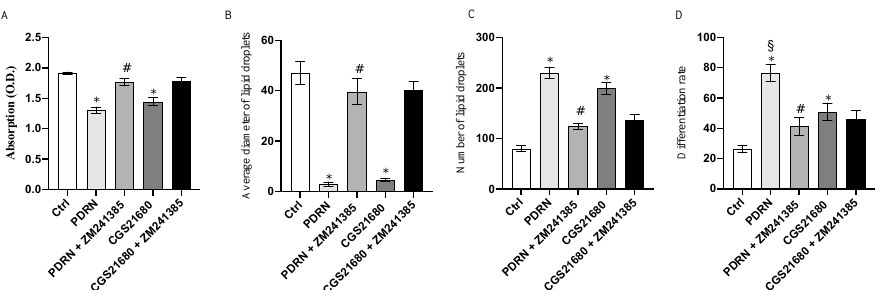
Figure 3. The graphs represent Od 500 Oil Red O values ( A ), lipid droplet size ( B ), number of lipid droplets ( C ) and adipocyte differentiation rate ( D ) obtained from each group. Values are expressed as the means and SD. N = 3 experiments; * p < 0.0001 vs. CTRL; # p < 0.0001 vs. PDRN; § p < 0.001 vs. CGS21680. Figure 2. The panel shows differentiated adipocytes stained by Oil Red O staining of CTRL ( A ), PDRN ( B ), PDRN + ZM241385 ( C ), CGS21680 ( D ) and CGS21680 + ZM241385 ( E ). Scale bar 20 µm.